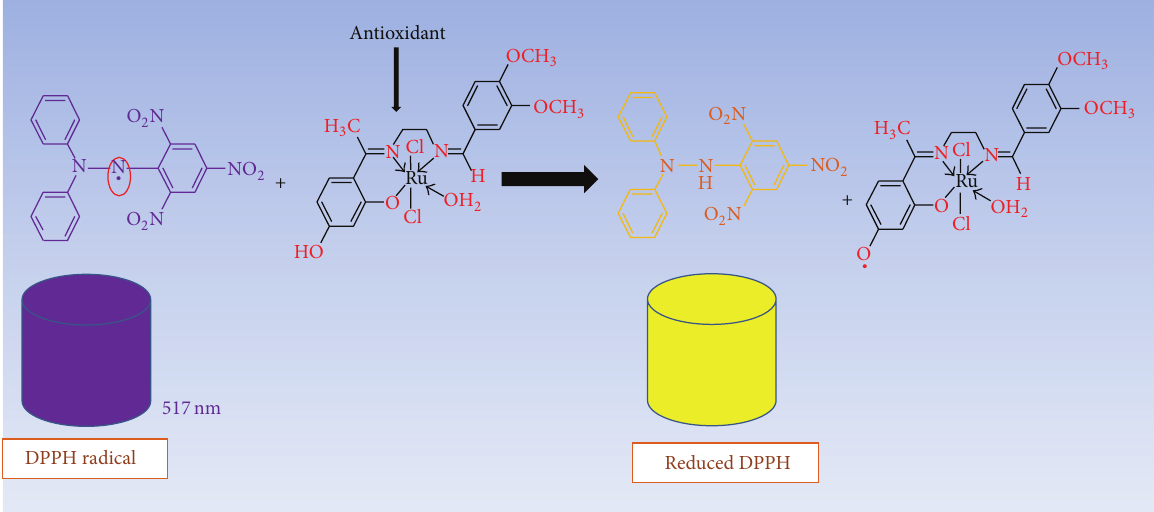
Scheme 2: Conversion of DPPH ∗ (purple) to its corresponding hydrazine form (yellow) by the addition of Ru(III) compounds to DPPH ∗